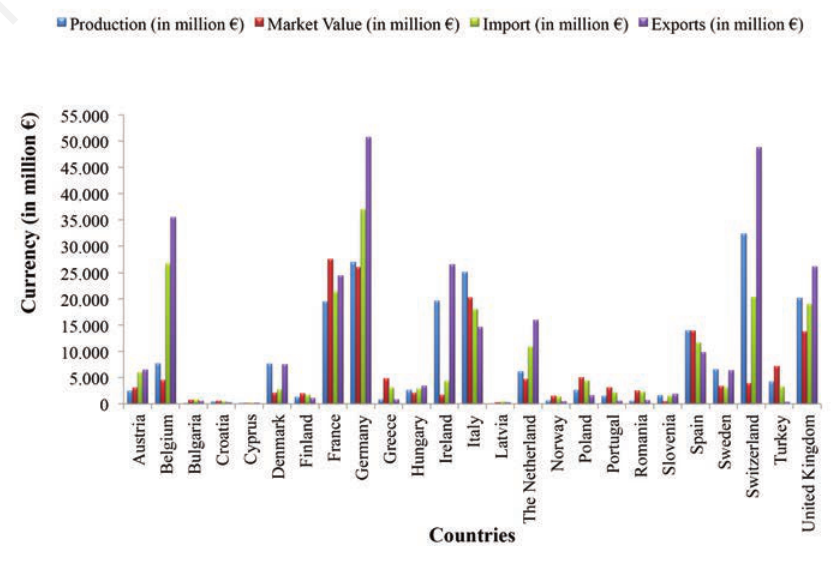
Figure 2. Statistical representation of pharmaceutical’s market